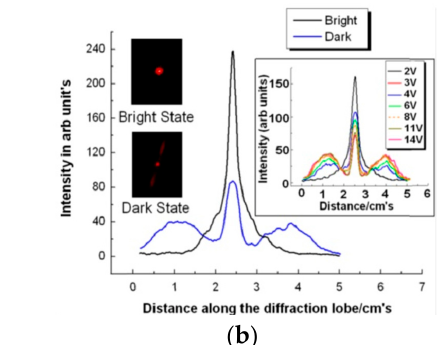
along the diffraction lobe. The left insertion shows the photograph of the bright and dark state under